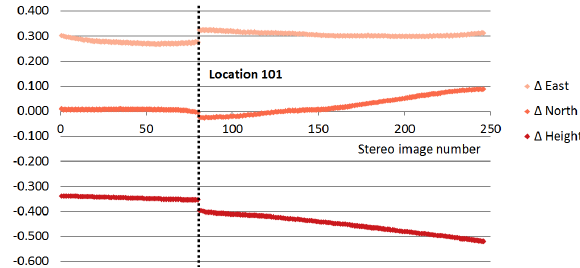
Figure 6. Deviations of projection centers in m for sequence 1.0